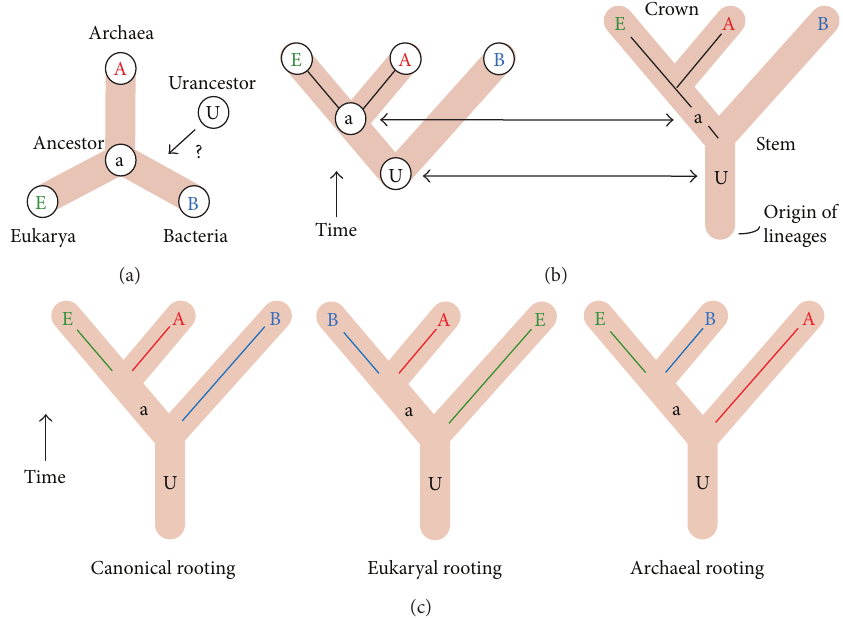
Figure 1: Rooting the tree of life (ToL): an exercise for “tree-thinkers.” (a) A node-based tree representation of the ToL focuses on taxa (sampled or inferred vertices illustrated with open circles) and models edges as ancestry relationships. The unrooted tree describes taxa as conglomerates of extant species for each domain of life, Archaea (A), Bacteria (B), and Eukarya (E) (abbreviations are used throughout the paper). Adding a universal ancestor vertex (rooting the ToL) implies adding a reconstructed entity (urancestor) that roots the tree but does not model ancestry relationships. The vertex is either a “most recent universal ancestor” if one defines it from an ingroup perspective or a “last universal common ancestor” (LUCA) if the definition relates to an outgroup perspective. Rooting the tree enables defining “total lineages,” which are lists of ancestors spanning from the ancestral taxon to the domain taxa. (b) A stem-based view focuses on edges (branches), which are sampled, and inferred ancestral taxa are viewed as lineages under the paradigm of descent with modification. Vertices correspond to speciation events. Terminal edges represent conglomerates of lineages leading to domains of life (the terminal nodes of node-based trees) and the ancestral stem represents the lineage of the urancestor (U) (double arrowhead line). Total lineages are simply a chain of edges that goes back in time and ends in the ancestral stem. Both node-based and stem-based tree representations are mathematically isomorphic but they are not equal [154]. They change the concept of monophyletic and paraphyletic relationships. A node-based clade starts with a lineage at the instant of the splitting event, incorporating the ancestor into the makeup of the clade. In contrast, a stem-based clade originates with a planted branch on the tree, where the branch represents a lineage between two lineage splitting events. Planting an ancestral stem defines an origin of lineages and the first speciation event in the record of life. This delimits a crown clade of two domain lineages in the stem-based tree (labeled with black lines) that includes the ancestor of the sister groups, a, and a stem domain group at its base. (c) The three possible rootings of the ToL depicted with stem-based tree representations. Terminal edges are labeled with thin lines and these conglomerate lineages can include stem and crown